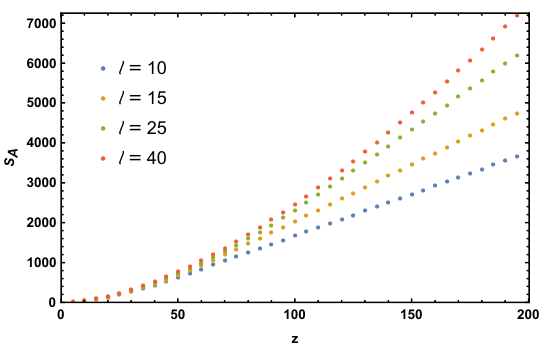
Figure 6 . EE as a function of z for entangling regions with di(cid:11)erent lengths. Here we have set N =